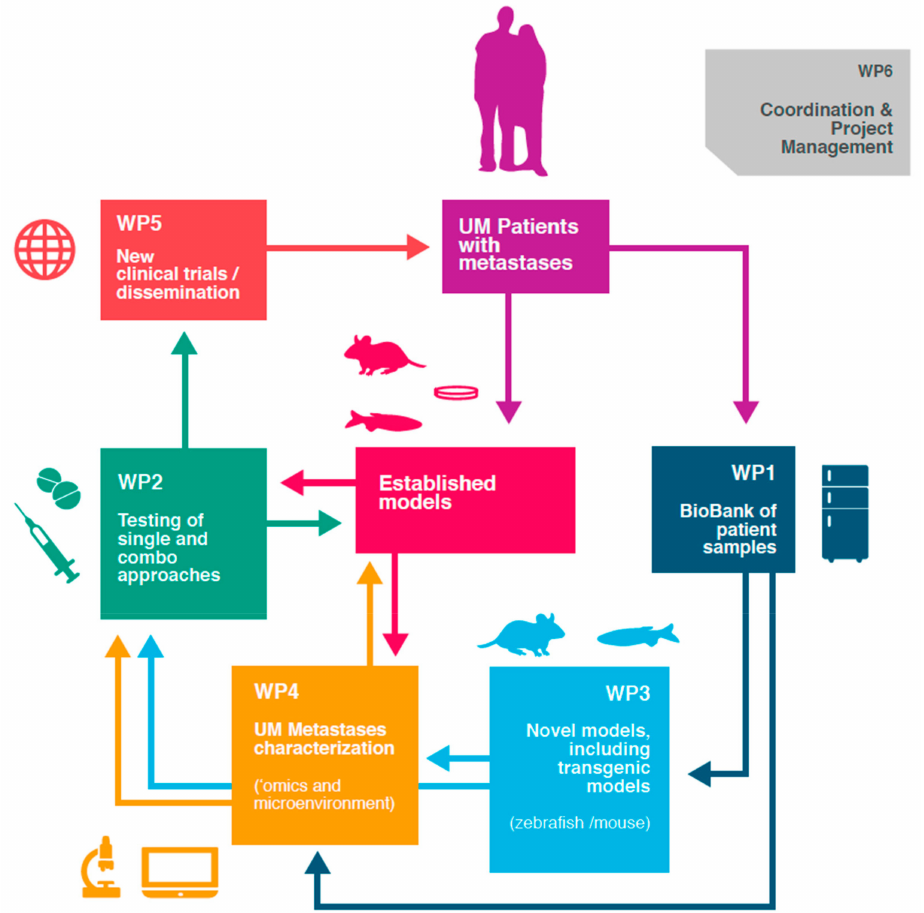
Figure 1. Schematic representation of the UM Cure 2020 work plan. New knowledge of the biology of UM metastases is generated though the characterisation of patient samples (work package (WP1)), the development of genetically modified models (WP3) and several omics approaches (WP4). New therapeutic hypotheses are tested as single agents and combinations (WP2) using relevant preclinical models (WP3), with the objective to translate those findings in the clinic (WP5). Patients are participating in every step of our research, supported by a growing European patient network